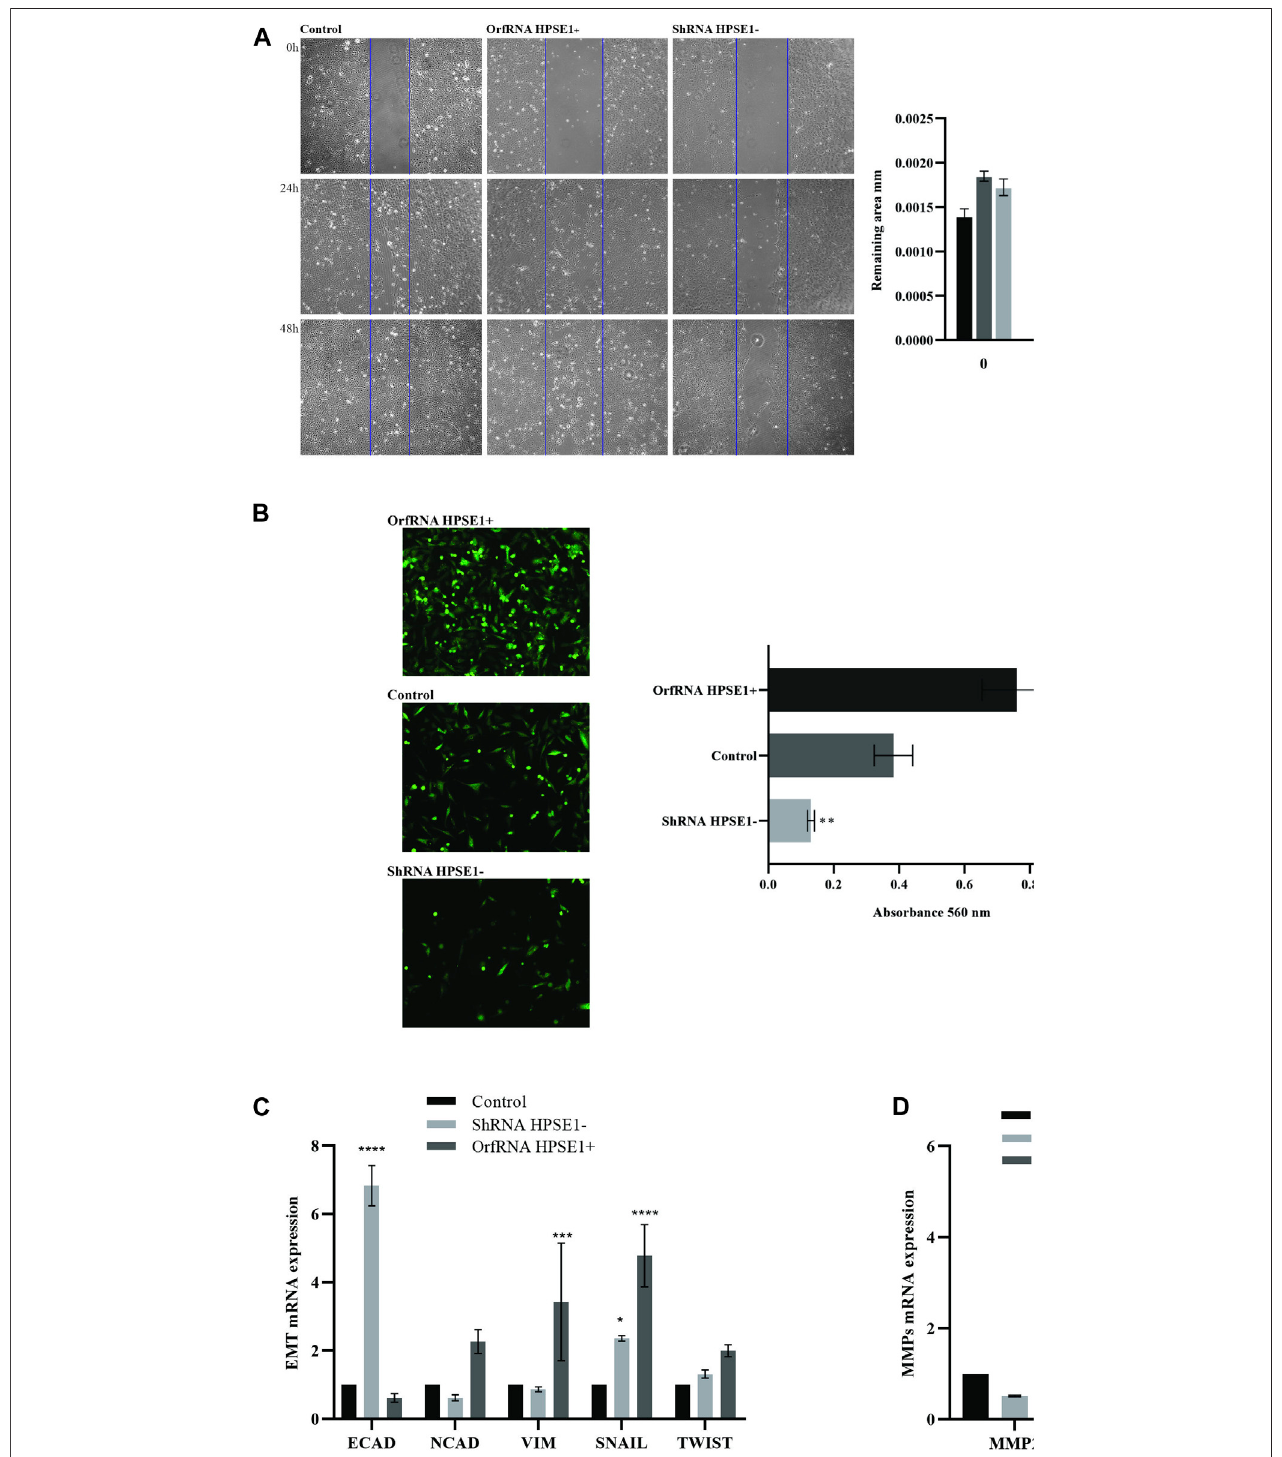
FIGURE 5 | Overexpression of HPSE1 is associated with migration, invasion, ECM remodeling, and acquisition of EMT properties. (A) Photomicrographs of cell linesweretaken 0,24,and 48 hafter wounding(40X). Theaveragewidth ofthelacunae wasmeasured.MigrationofSCC-9 cellswassigni fi cantlydecreasedinHPSE1- silenced cells (ShRNA HPSE1 − ) and increased in HPSE1-upregulated clones (OrfRNA HPSE1+). Migration analysis based on this assay showed that cells with lower expression of HPSE1 closed the scratch wound signi fi cantly slower than the SCC9 Control cells. (B) Invasion of SCC-9 cells was signi fi cantly inhibited by HPSE1 knockdown, and signi fi cantly enhanced after its upregulation. (C) Analysing EMT markers, the downregulation of HPSE1 signi fi cantly induced the expression of